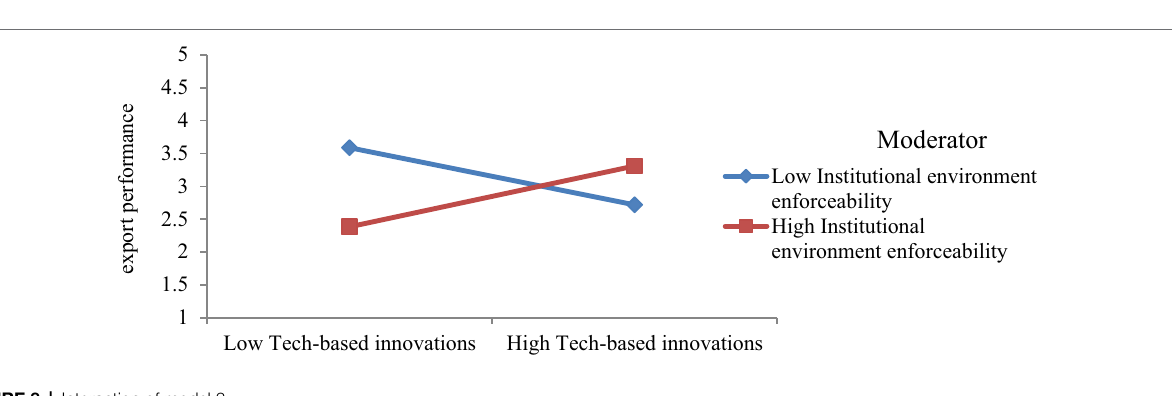
FIGURE 8 | Interaction of model 3.